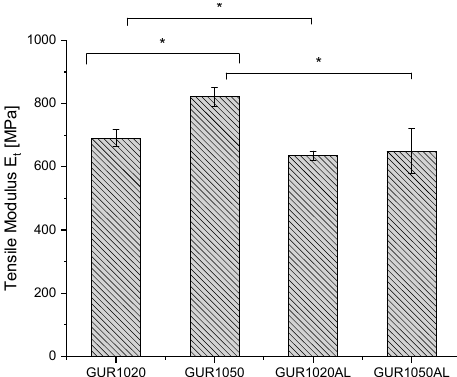
Figure 5. Tensile moduli comparison for various ultra-high molecular weight polyethylene (UHMWPEs), (*) p < 0.05. Measurements taken with a Zwick Z005 universal testing machine in accordance with DIN EN ISO 527, N = 6.